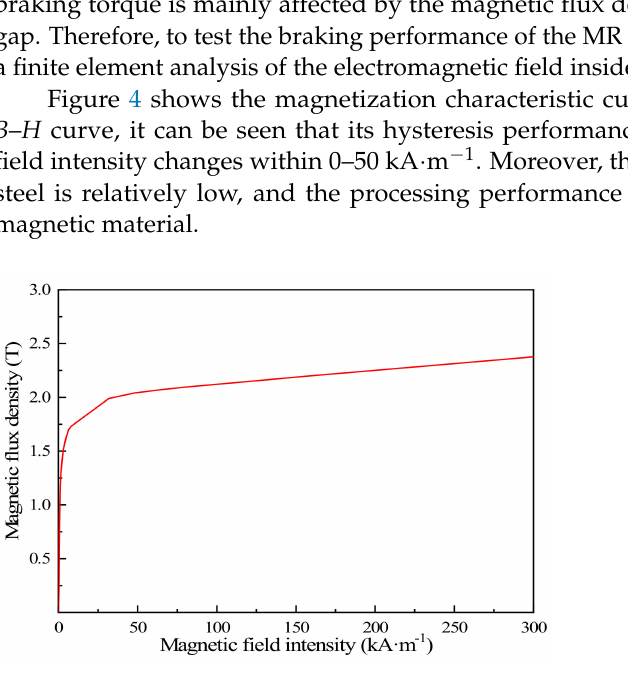
Figure 4. B – H curve of No. 10